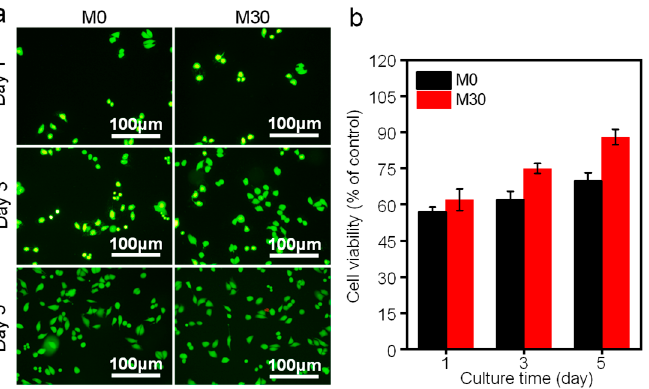
Figure 9. ( a ) Cell morphology and ( b ) cell viability results for MG-63 cells after 1, 3, and 5 d culture in M0 and M30